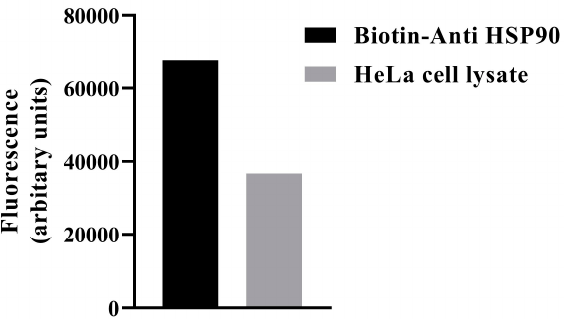
Figure 10. Fluorescence microscopy measurements showed a decrease in fluorescence when a com- parison was made between the attachment of biotinylated antibodies to Sav-QDs and the attachment of HSP90 α present in HeLa cell lysate to these biotinylated antibodies. Confirming the overall binding of HSP90 α present in a complex biological sample such as Hela cell lysate to biotinylated antibodies attached to Sav-QDs. Fluorescence is plotted against samples used for attachment of HSP90 α or biotinylated antibodies to Sav-QDs present in PBS buffer.